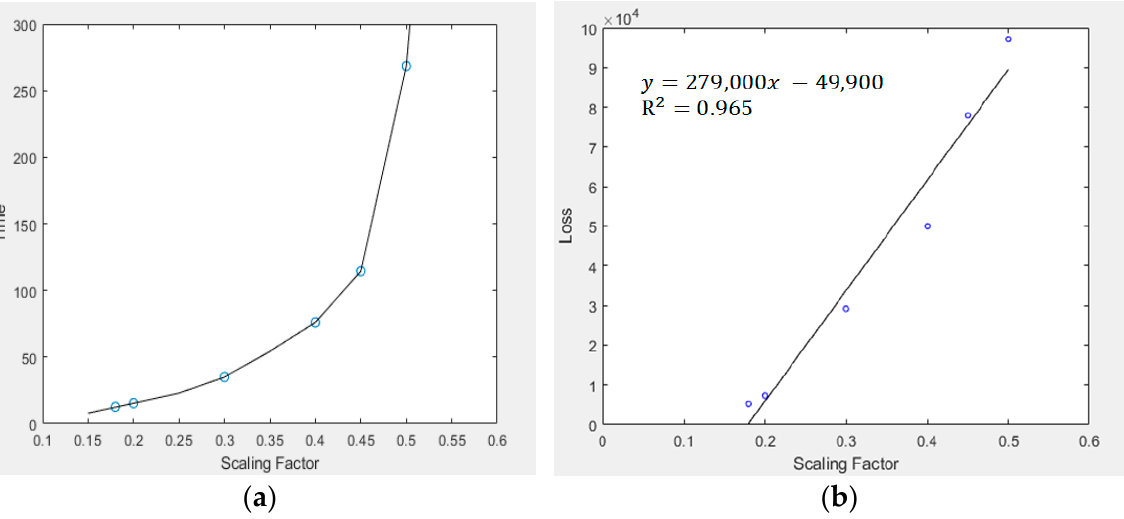
Figure 10. ( a ) Time consumed for ten image-generation process (in s) versus scaling factor imposed in the model; ( b ) Average loss of the ten image-generation process versus scaling factor imposed in the